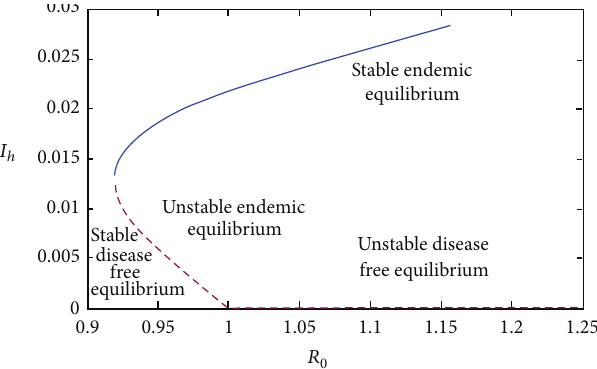
Figure 1: Simulations of the model (4) illustrating the phenomenon of backward